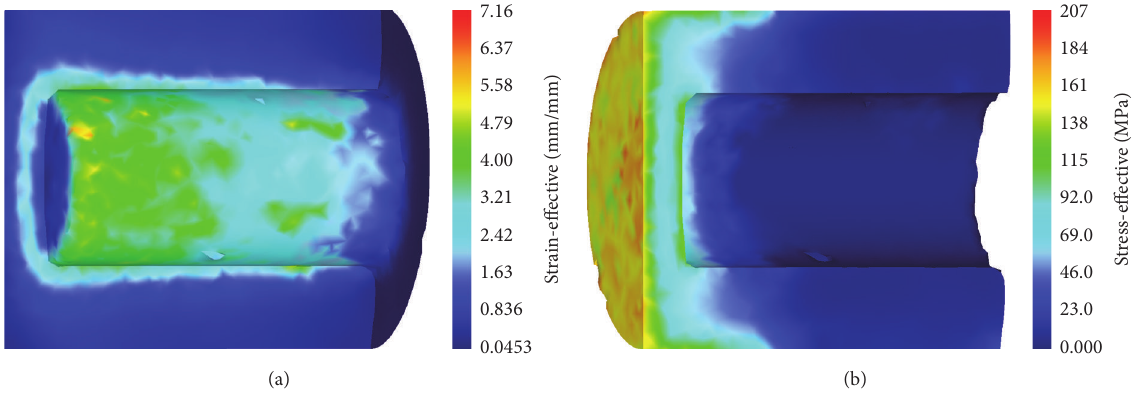
Figure 18: Simulation result of billet deformed with the elements number of 40177: (a) strain; (b) stress.